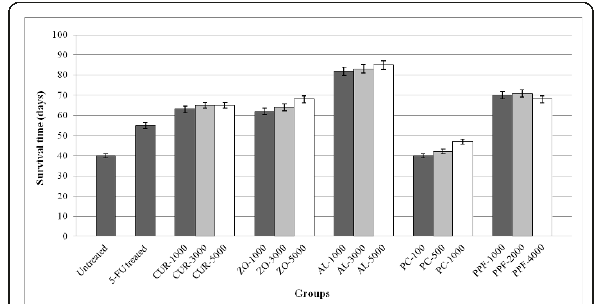
Figure 3 Anti-CCA activities indicated by prolongation of survival time (mean ± SEM), of CUR compound and extracts of ZO, AL, PC, and PPF at various dose levels, in comparison with NSS (untreated control) and 5-FU (reference control) in CCA- xenografted nude mice during the 85 days investigation period . Statistically significant difference by ANOVA, followed by post hoc scheffe test: AL-treated group at low dose level vs. control group (p < 0.001). AL-treated group at medium dose level vs. control group (p < 0.001). AL-treated group at high dose level vs. control group (p <